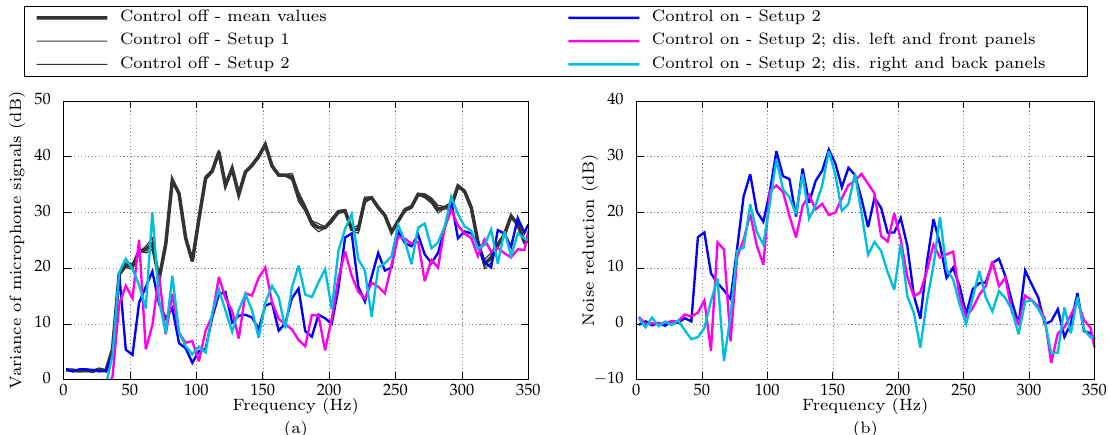
Figure 17. ( a ) The average variance of the room microphone signals for each of the primary noise tones with and without active control and ( b ) the averaged noise reduction for the noise sensed by the room microphones for each of the primary noise tones. Observe, only active control with Setup 2, Setup 2 with the actuators on the left and the front panel disabled and Setup 2 with the actuators on the right and the back panel disable, d 1 = 0.1 m.